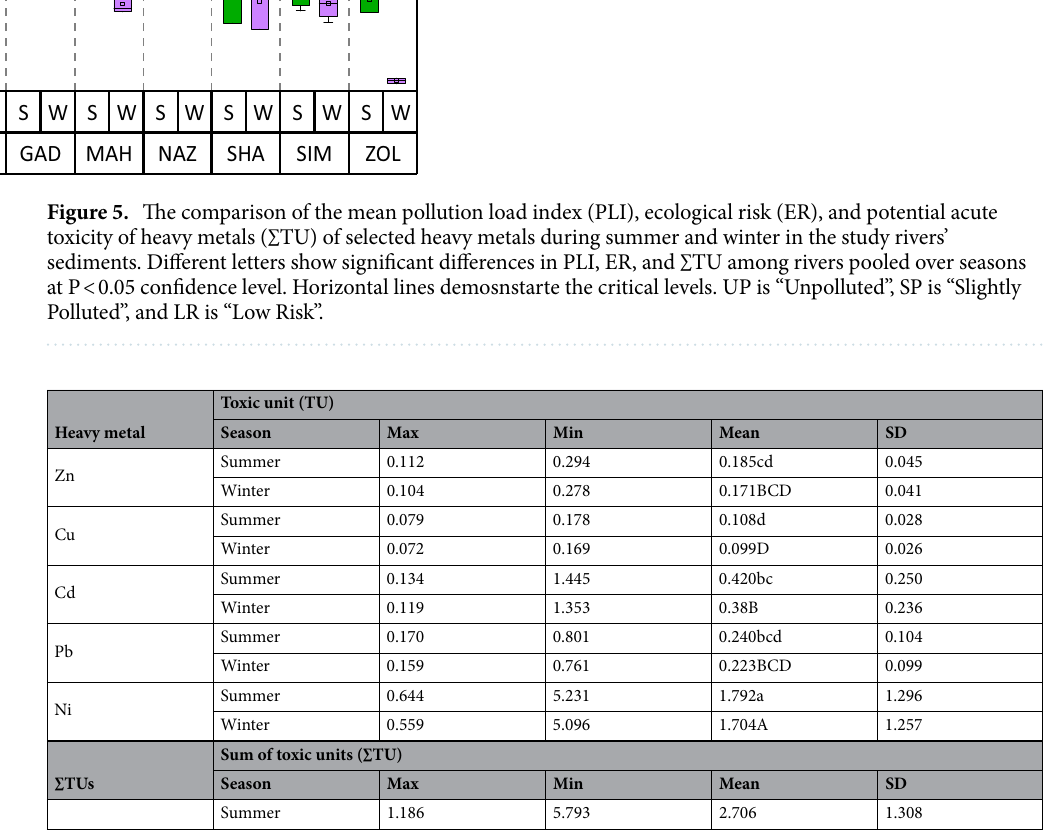
Table 5. The level of toxic unit, sum of toxic units, and modified Hazard Quotient of the heavy metals during summer and winter. The capital letters separate means of winter sediments’ heavy metal concentrations and lower-case letters separate the summer sediments’ mean values according to Fisher’s least significant difference (LSD) test at 95% confidence interval.